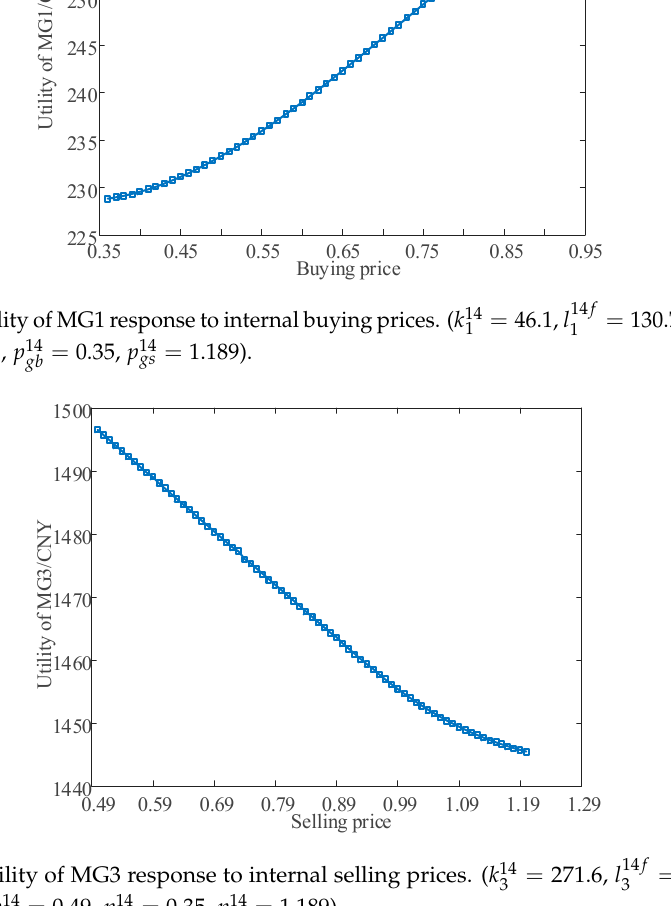
= 271.6, l 14 f = 227.4, pv 14 = 3 3 3 3